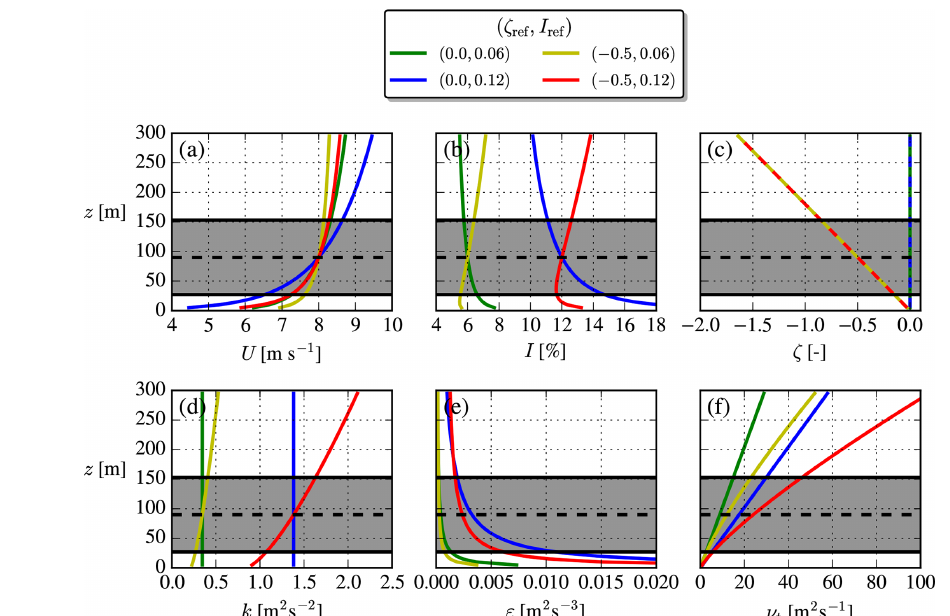
Figure 1. Analytical MOST profiles. Combinations of low/high TI and neutral/unstable stability. The rotor area of a NREL5MW turbine is shown. Dashed lines are used for ζ to make all profiles visible.